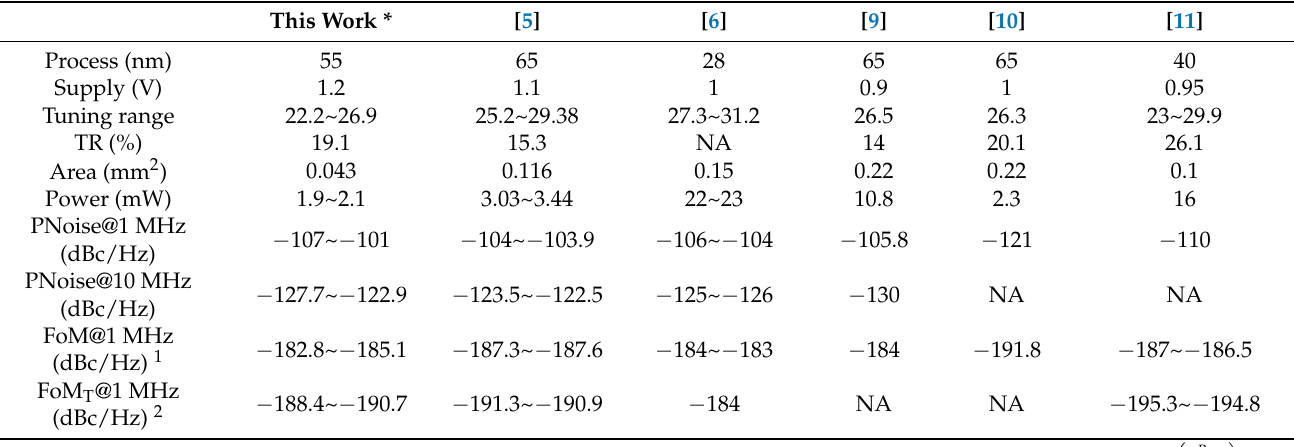
Figure 13. FoM and FoM T vs. frequency. Table 1. Performance summary of different VCOs.